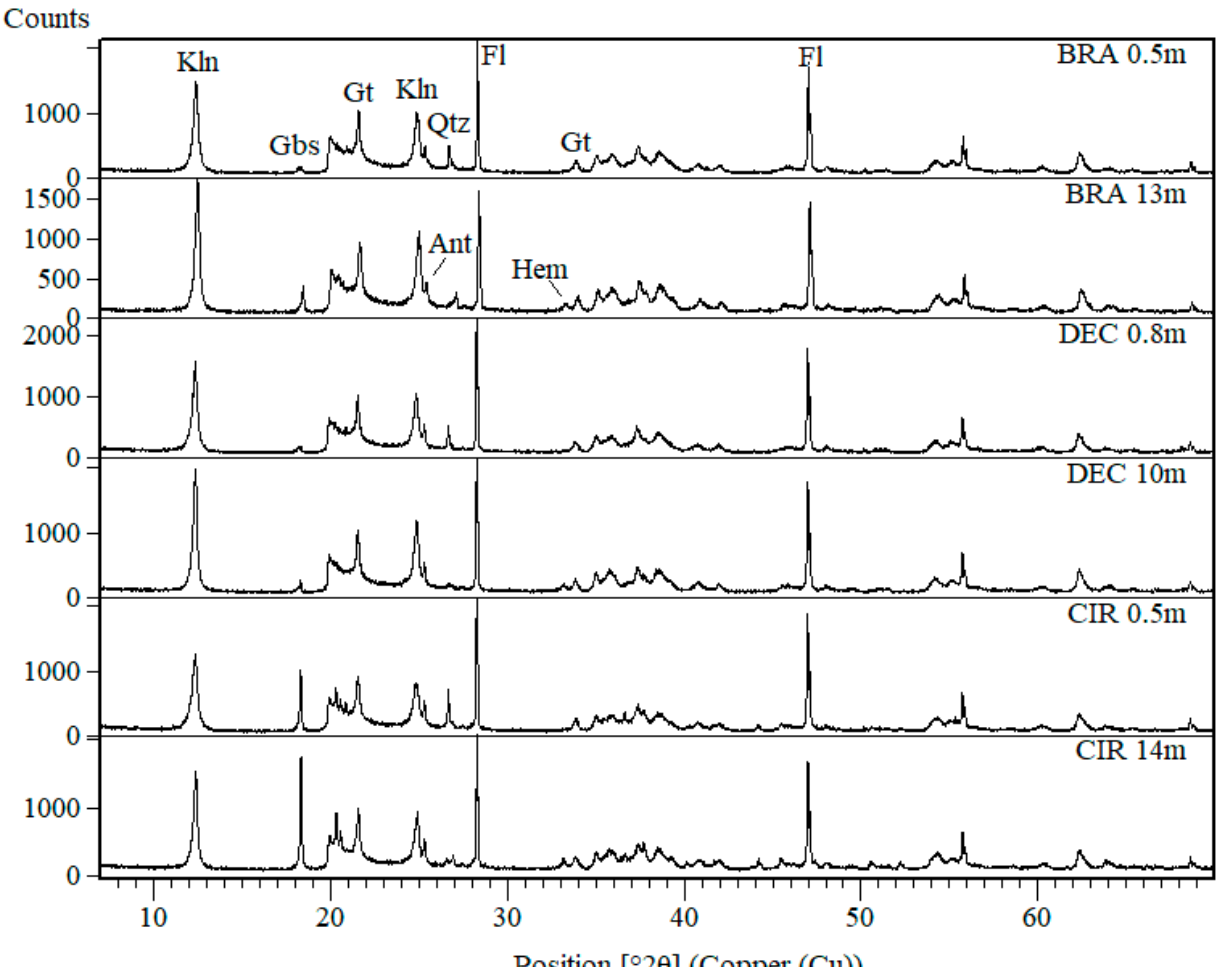
Figure 3. X-ray diffractograms of selected BTC samples spiked with fluorite (Fl). Kln: kaolinite; Gbs: gibbsite; Gt: goethite; Hem: hematite; Ant: anatase; and Qtz: quartz.